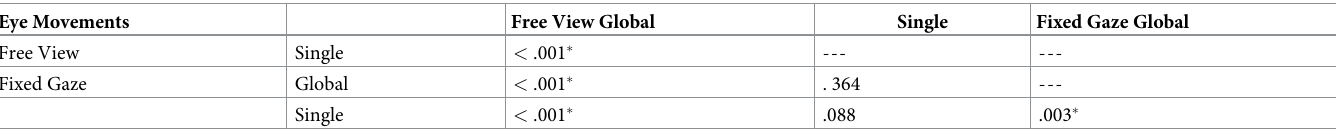
Table 1. p-values–t-tests for configurations in Experiment 1 across